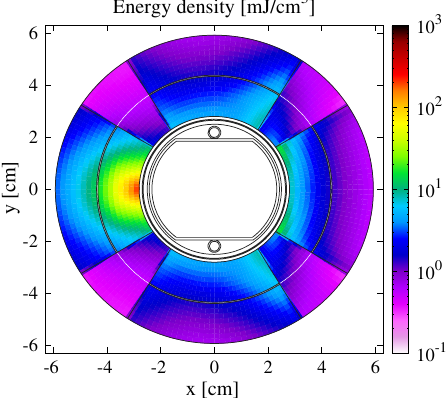
FIG. 15. Simulated transverse energy density distribution from FLUKA in MQ.12L6 coils at the location where the maximum energy deposition occurs during the intermediate-duration orbit-bump quench test. Results correspond to 4 × 10 8 protons impacting on the magnet beam screen.